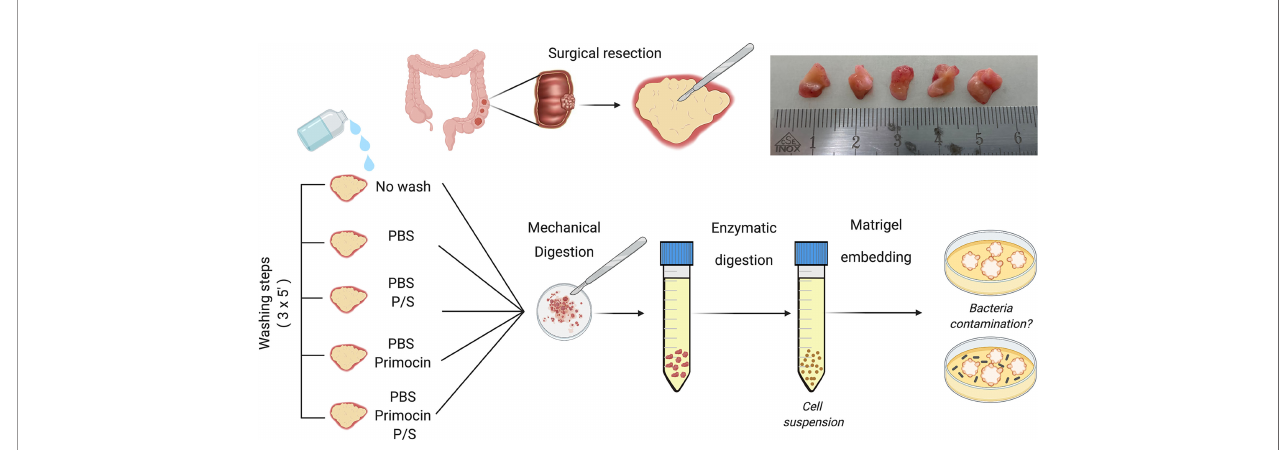
FIGURE 1 | Schematic representation of the tissue processing work fl ow for CRC organoid generation. Upon collection, CRC tissues were divided into 5 similar pieces. Each sample underwent a different washing condition as described in the methods (left). Samples were washed three times for 5 min while maintained on ice. After the washing step, all the tissues were processed using the same protocol and conditions. A cell suspension was generated using mechanical and enzymatic digestion that was then embedded in Matrigel and daily monitored for presence of microbial contamination. Created with